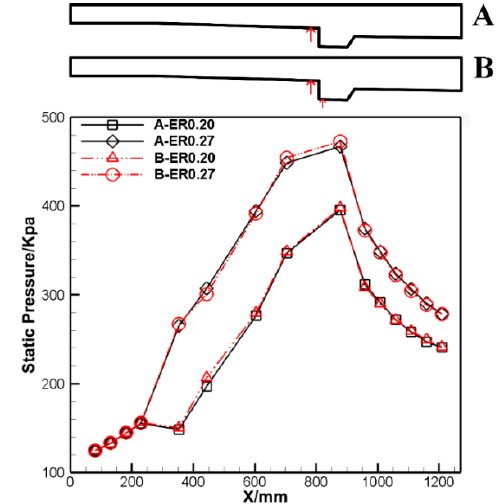
Figure 6. Comparison of the time-averaged static pressure distributions along the combustor bottom wall of different cases.